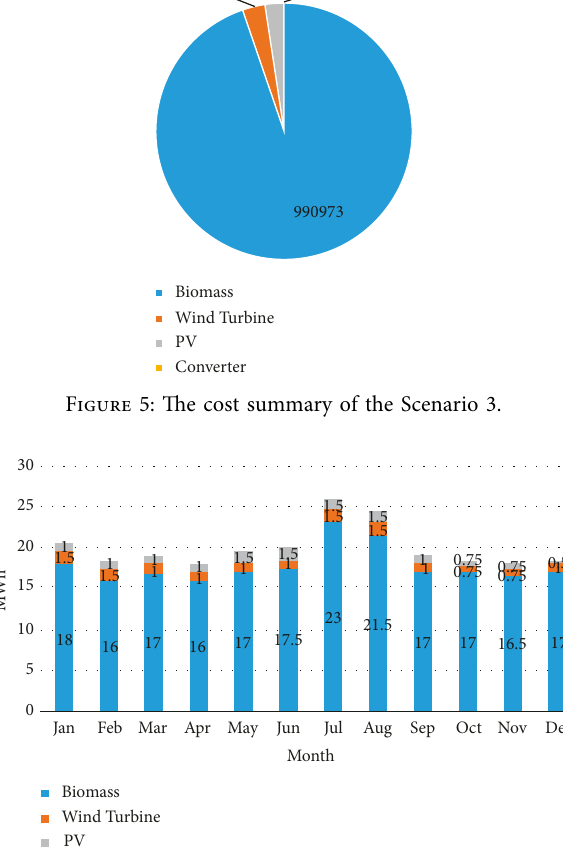
Figure 6: Monthly electric production in different months of the year (Scenario